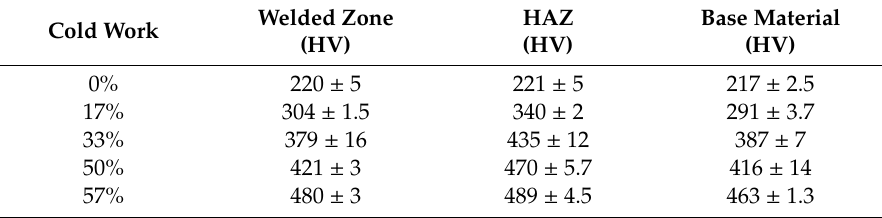
Table 2. Hardness test results in the welded, heat a ff ected and base material